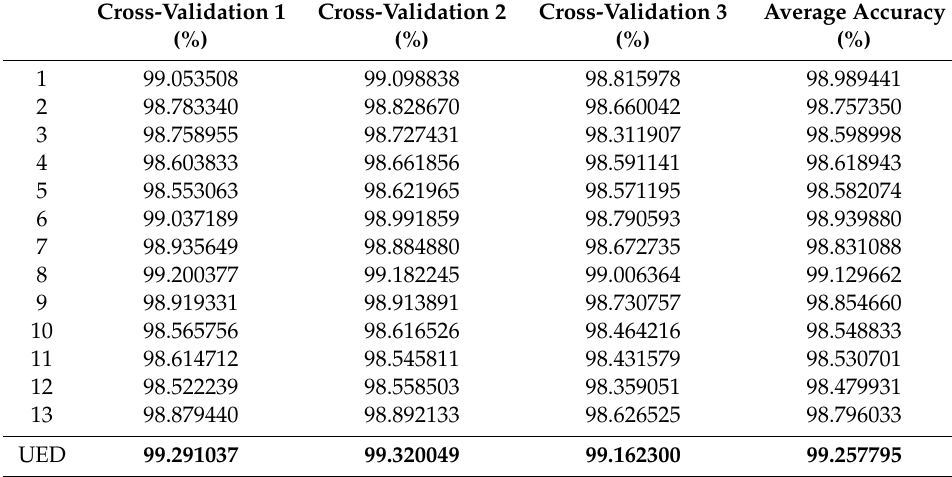
Table 9. Gender classification in the MORPH dataset using a hybrid of the weighting fusion method and